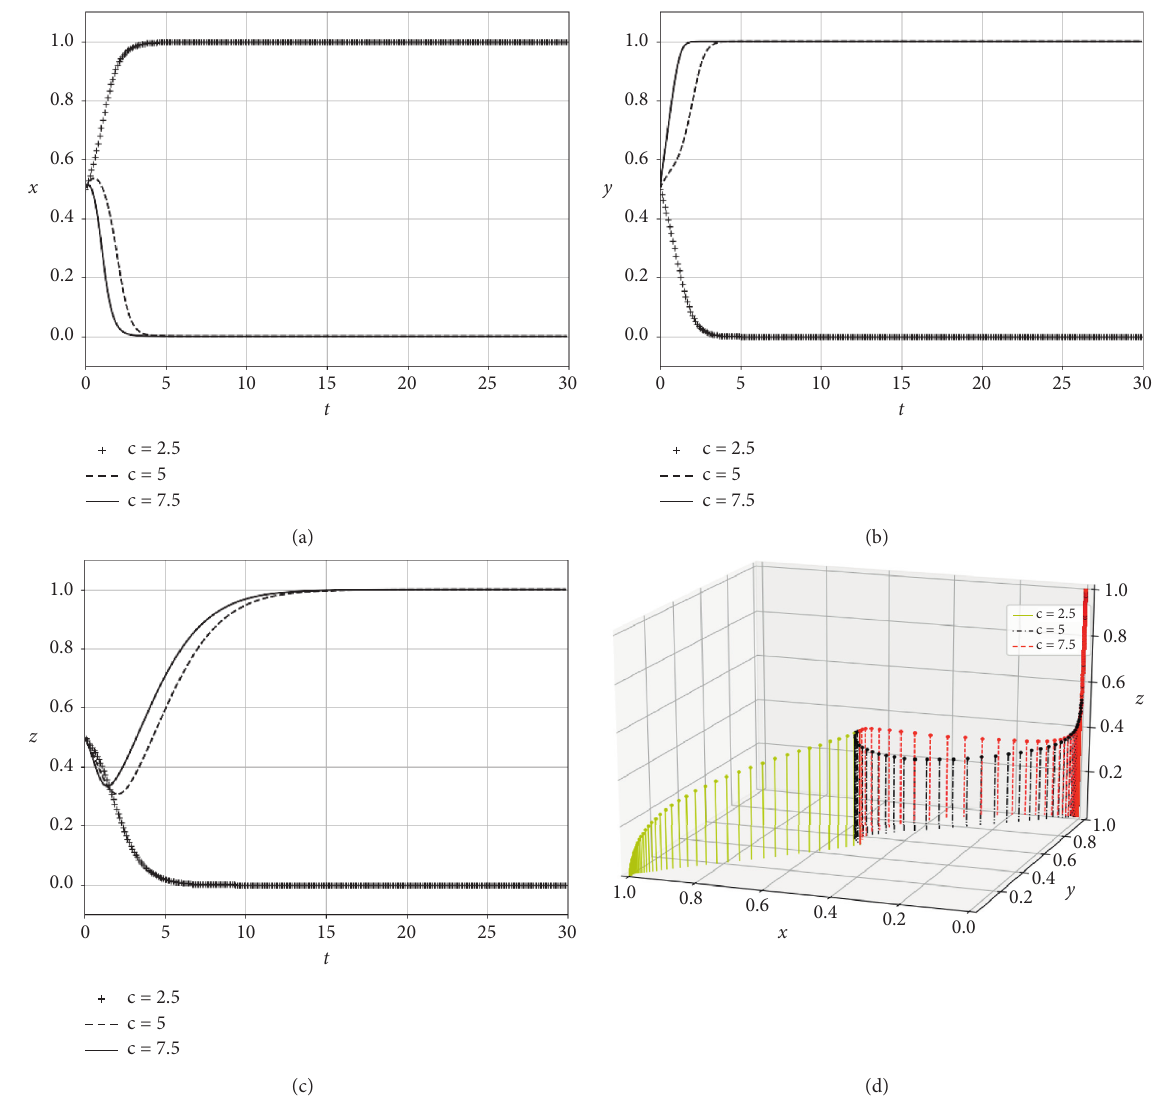
Figure 8: The evolution of the local government, the new media, and the local people, and the three parties under the different punishment of the local government to the rumor